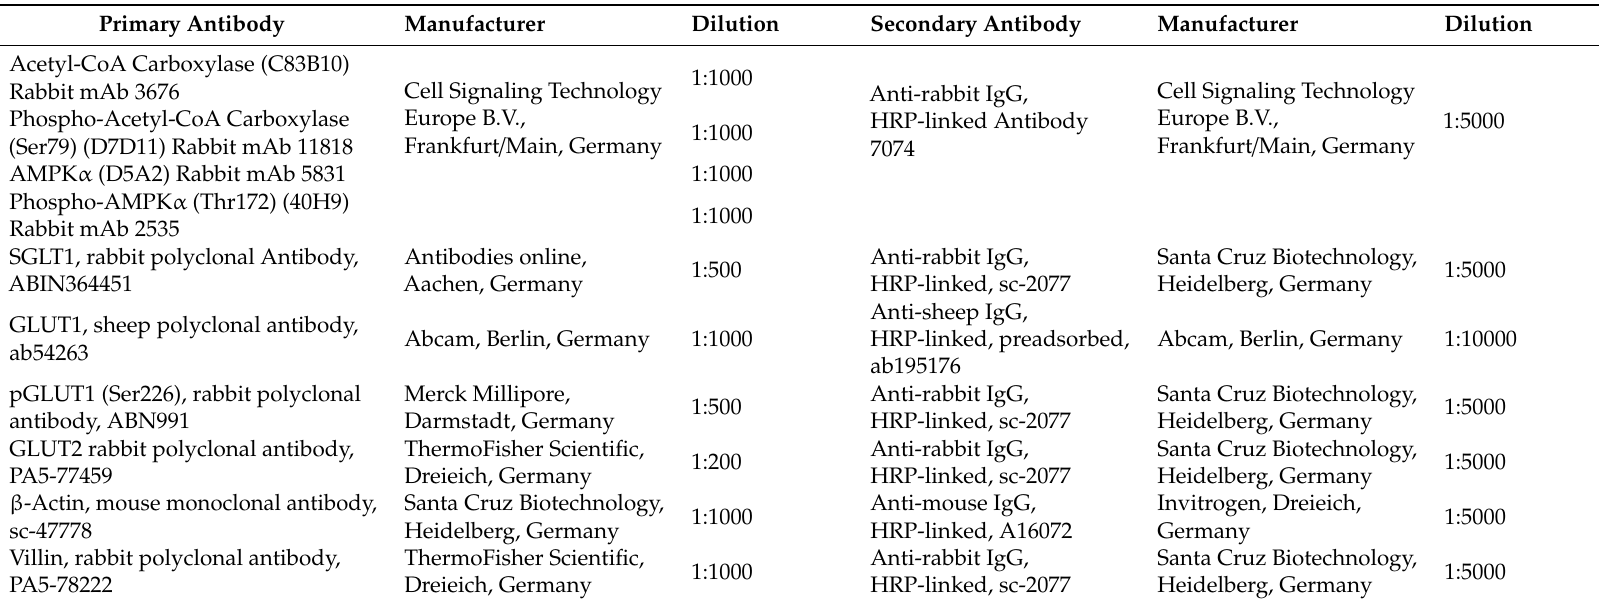
Table 1. Antibodies used for Western